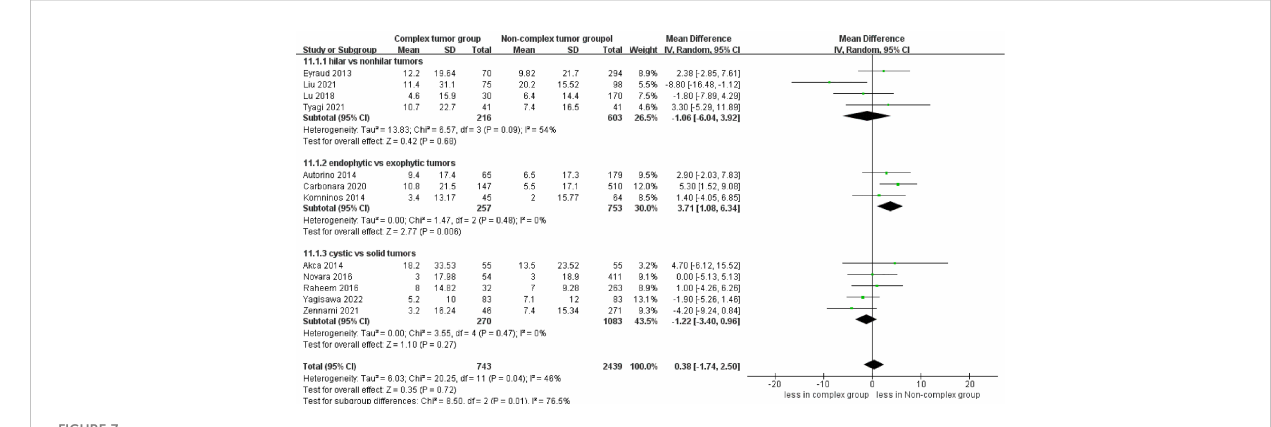
FIGURE 7 Forest plots of renal functional outcome- eGFR decline.